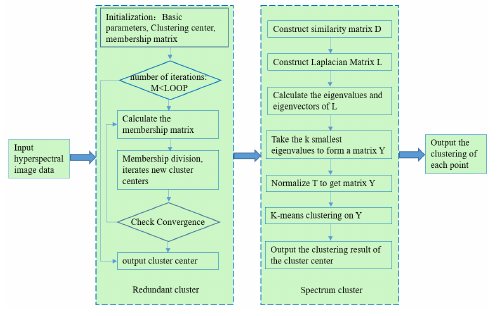
Figure 3. Flowchart of the co-clustering algorithm.